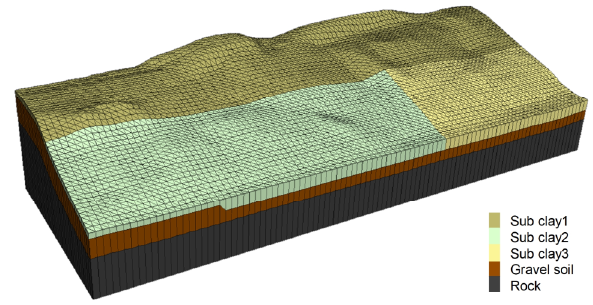
Figure 2. The 3D mesh model of the Shangtan landslide.